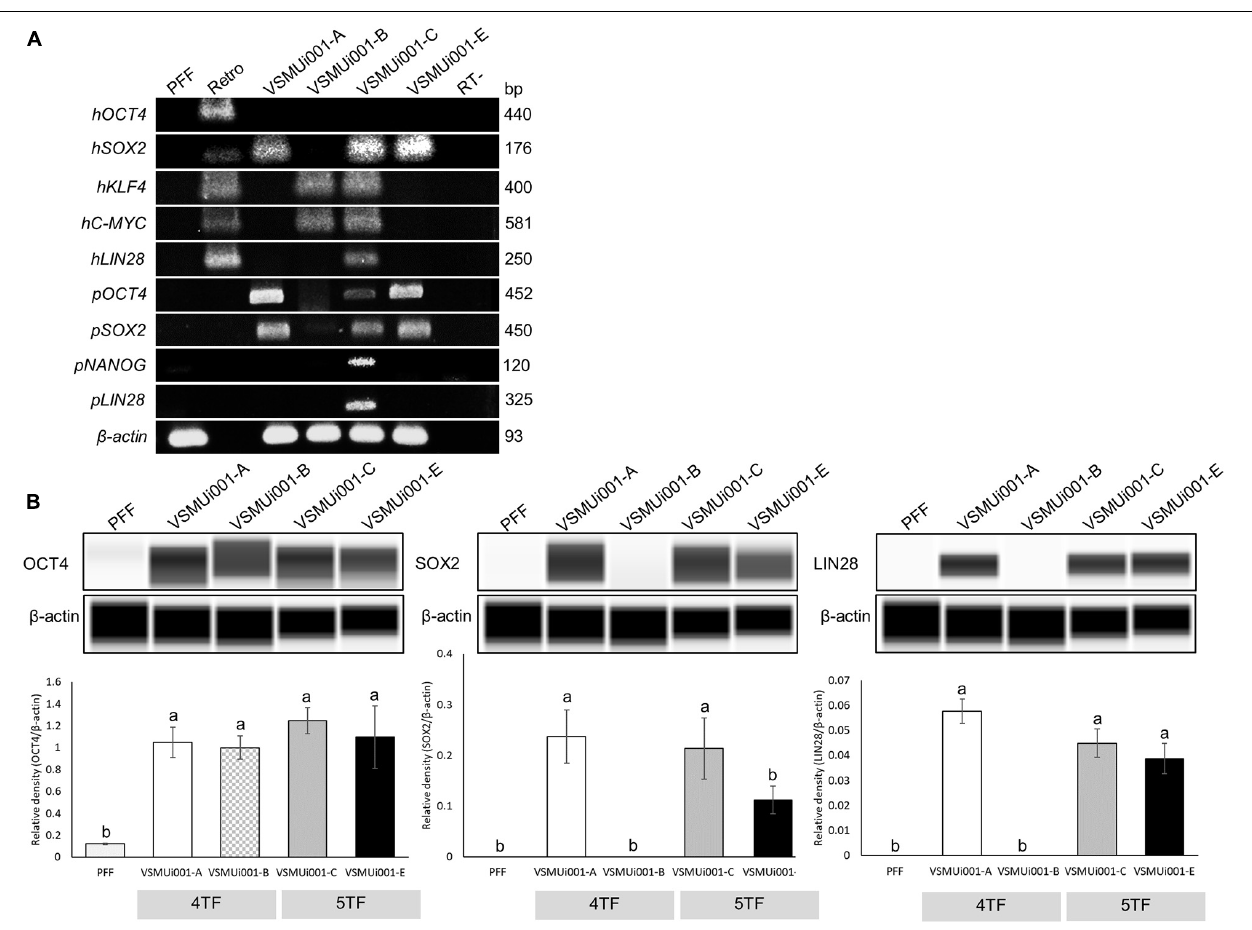
FIGURE 3 | Expression of pluripotency markers in various piPSC lines. (A) Expression of exogenous pluripotency genes ( hOCT4 , hSOX2 , hKLF4 , hC-MYC , and hLIN28 ) and endogenous pluripotency genes ( pOCT4 , pSOX2 , pNANOG , and pLIN28 ) in the PFFs and various piPSC lines. (B) Western blot images of endogenous pluripotent protein (OCT4, SOX2, and LIN28) expression and quantification of the western blot results. β -Actin was used as an internal control. Means with different lowercase letters are significantly different at P < 0.05. PFF, porcine fetal fibroblast; piPSCs, porcine-induced pluripotent stem cells; h , exogenous human gene; p , endogenous porcine gene; OCT4 , octamer-binding transcription factor 4; SOX2 , SRY-box transcription factor 2; KLF4 , Kruppel-like factor 4; C-MYC , MYC proto-oncogene, basic helix–loop–helix transcription factor; LIN28 , Lin-28 homolog A; NANOG , Nanog